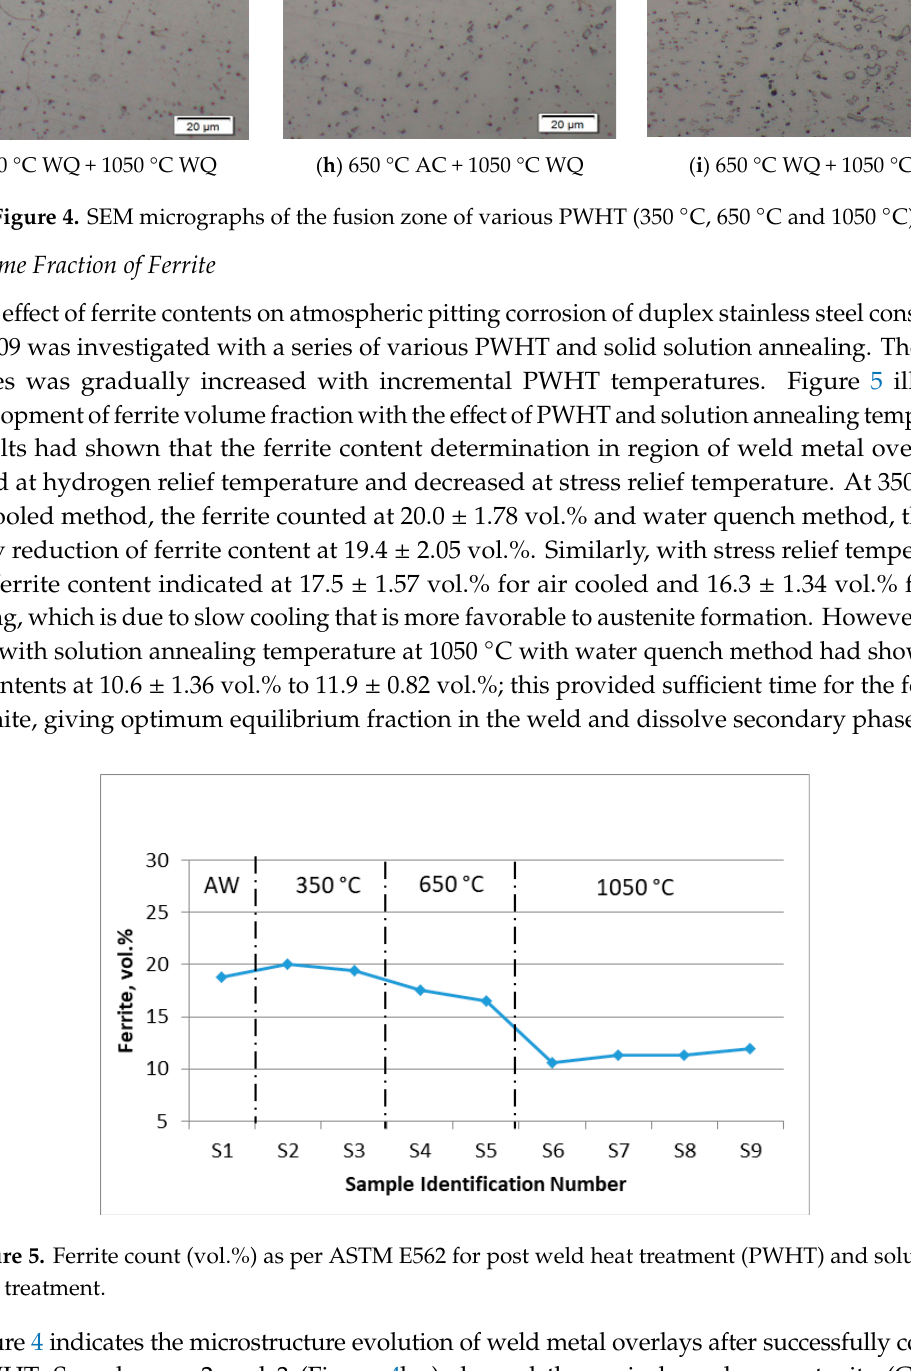
Figure 5. Ferrite count (vol.%) as per ASTM E562 for post weld heat treatment (PWHT) and solution heat treatment.